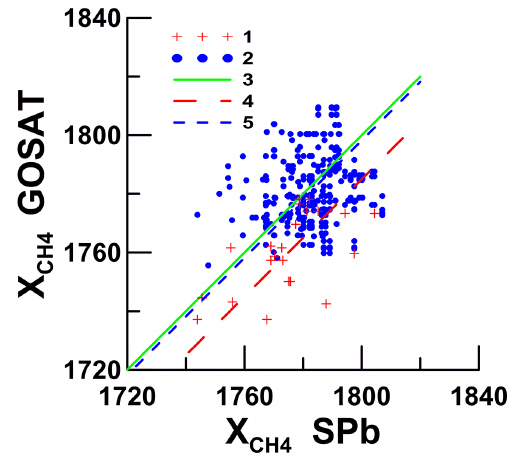
Fig. 2. Comparison of X CH (in ppb) measured near Saint Pe- 4 tersburg and with GOSAT satellite (data versions V01.xx – 1 and V02.xx – 2) when differences between the dates of measure- = ments do not exceed 2 days. Line 3 corresponds to X CH 4 _SPB X CH , lines 4 and 5 are shifted from line 3 by the average 4 _ GOS δX CH presented in Table 1 for GOSAT data versions V01.xx and 4 V02.xx, respectively. Fig. 3. Histograms of differences δX CH between pairs of measurements presented in Fig. 2 for GOSAT data versions V01.xx (a) and V02.xx (b) Figure 3. Histograms of differences d X measurements presented in Figure 2 for GOSAT data version V01.xx (a) and V02.xx (b). 4